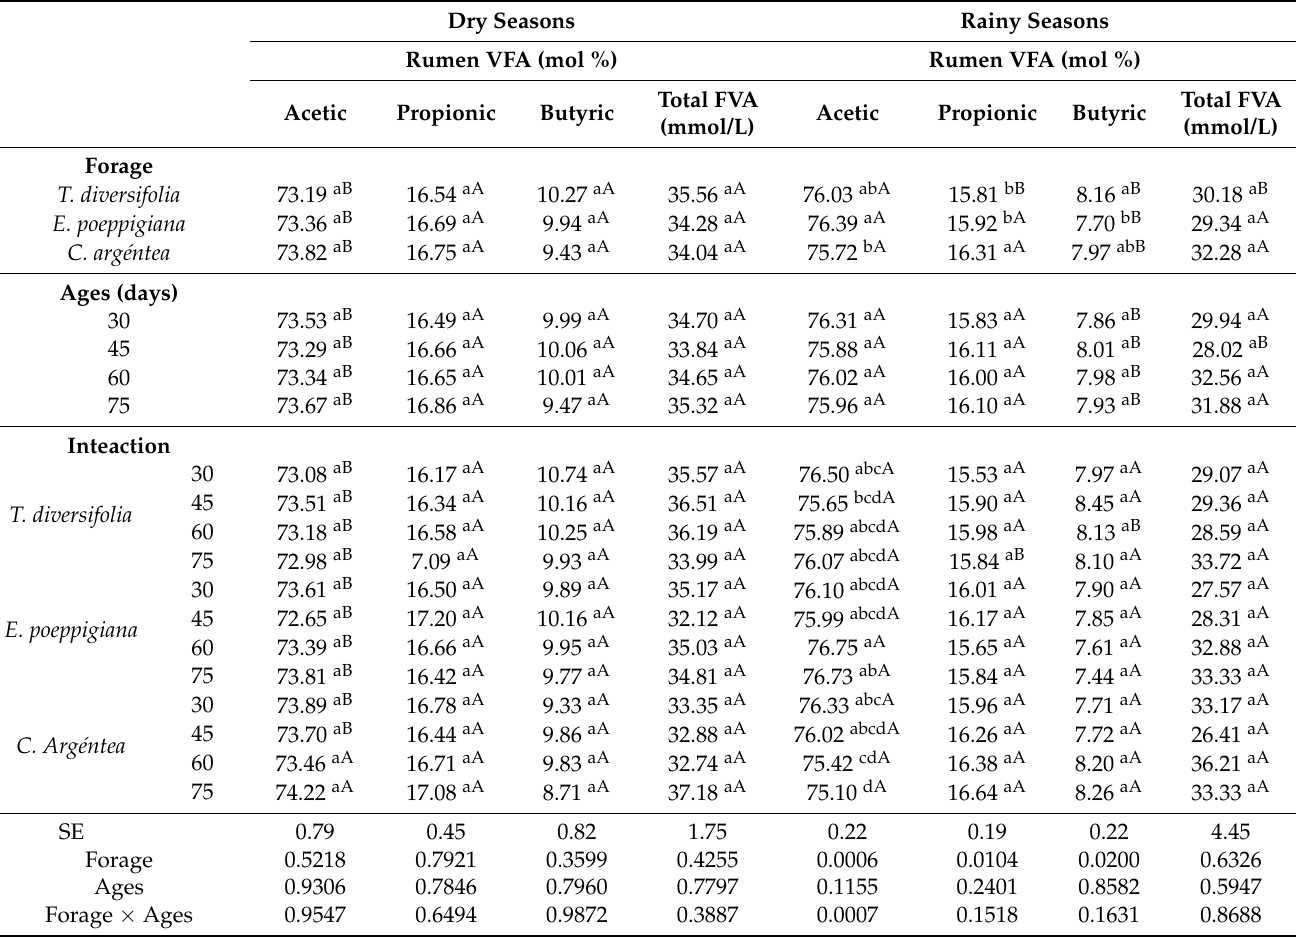
Table 3. In vitro proportion of volatile fatty acids in the rumen (mol %) of shrub and tree species at different cutting ages, in the dry and rainy